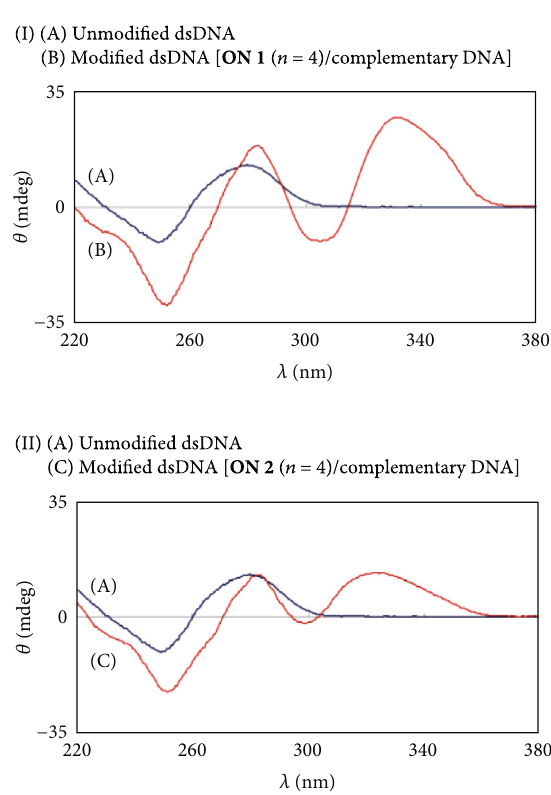
Figure 3: CD spectra of unmodi fi ed and modi fi ed